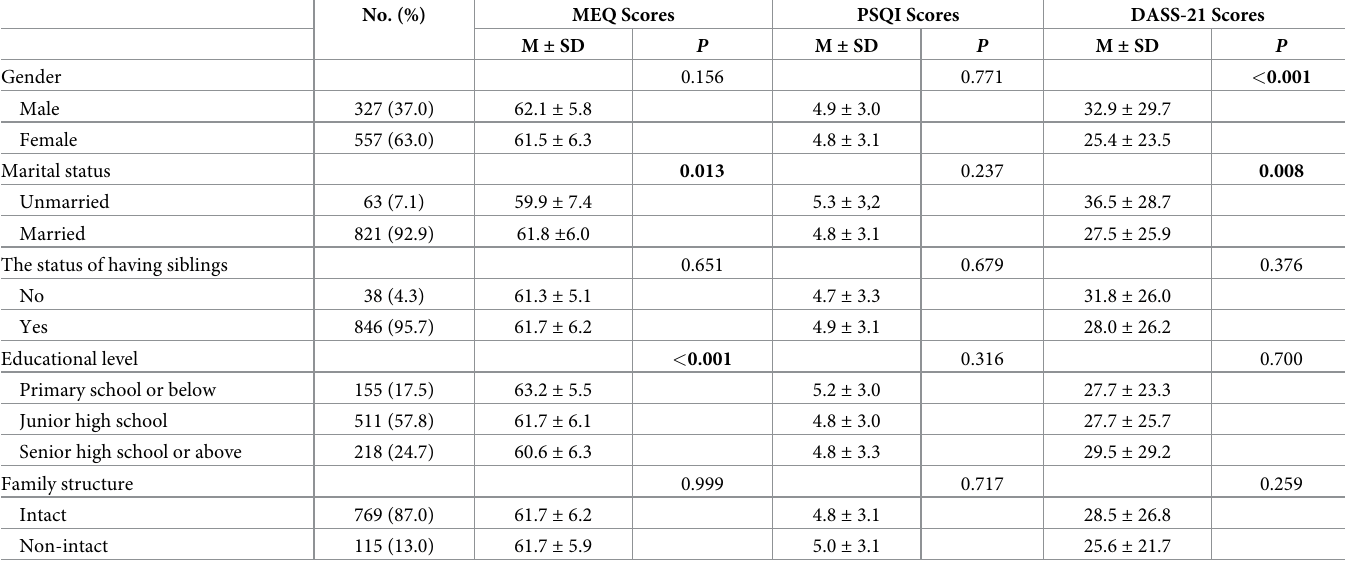
Table 1. Demographic characteristics and group comparisons of MEQ, PSQI and DASS-21 scores (n = 884).